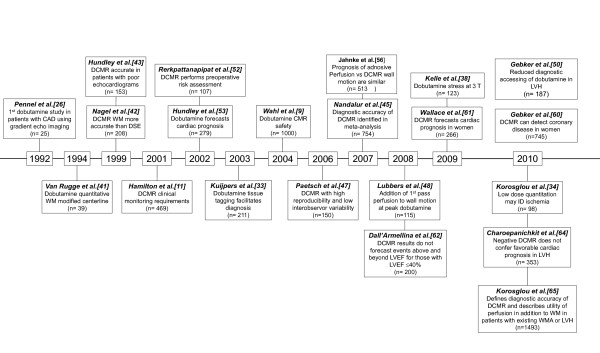
Timeline displaying the progression of dobutamine stress CMR research over the past 20 years. Each box represents a published manuscript of peer reviewed original research with the first author, a short summary, and the sample size (n) within the study.